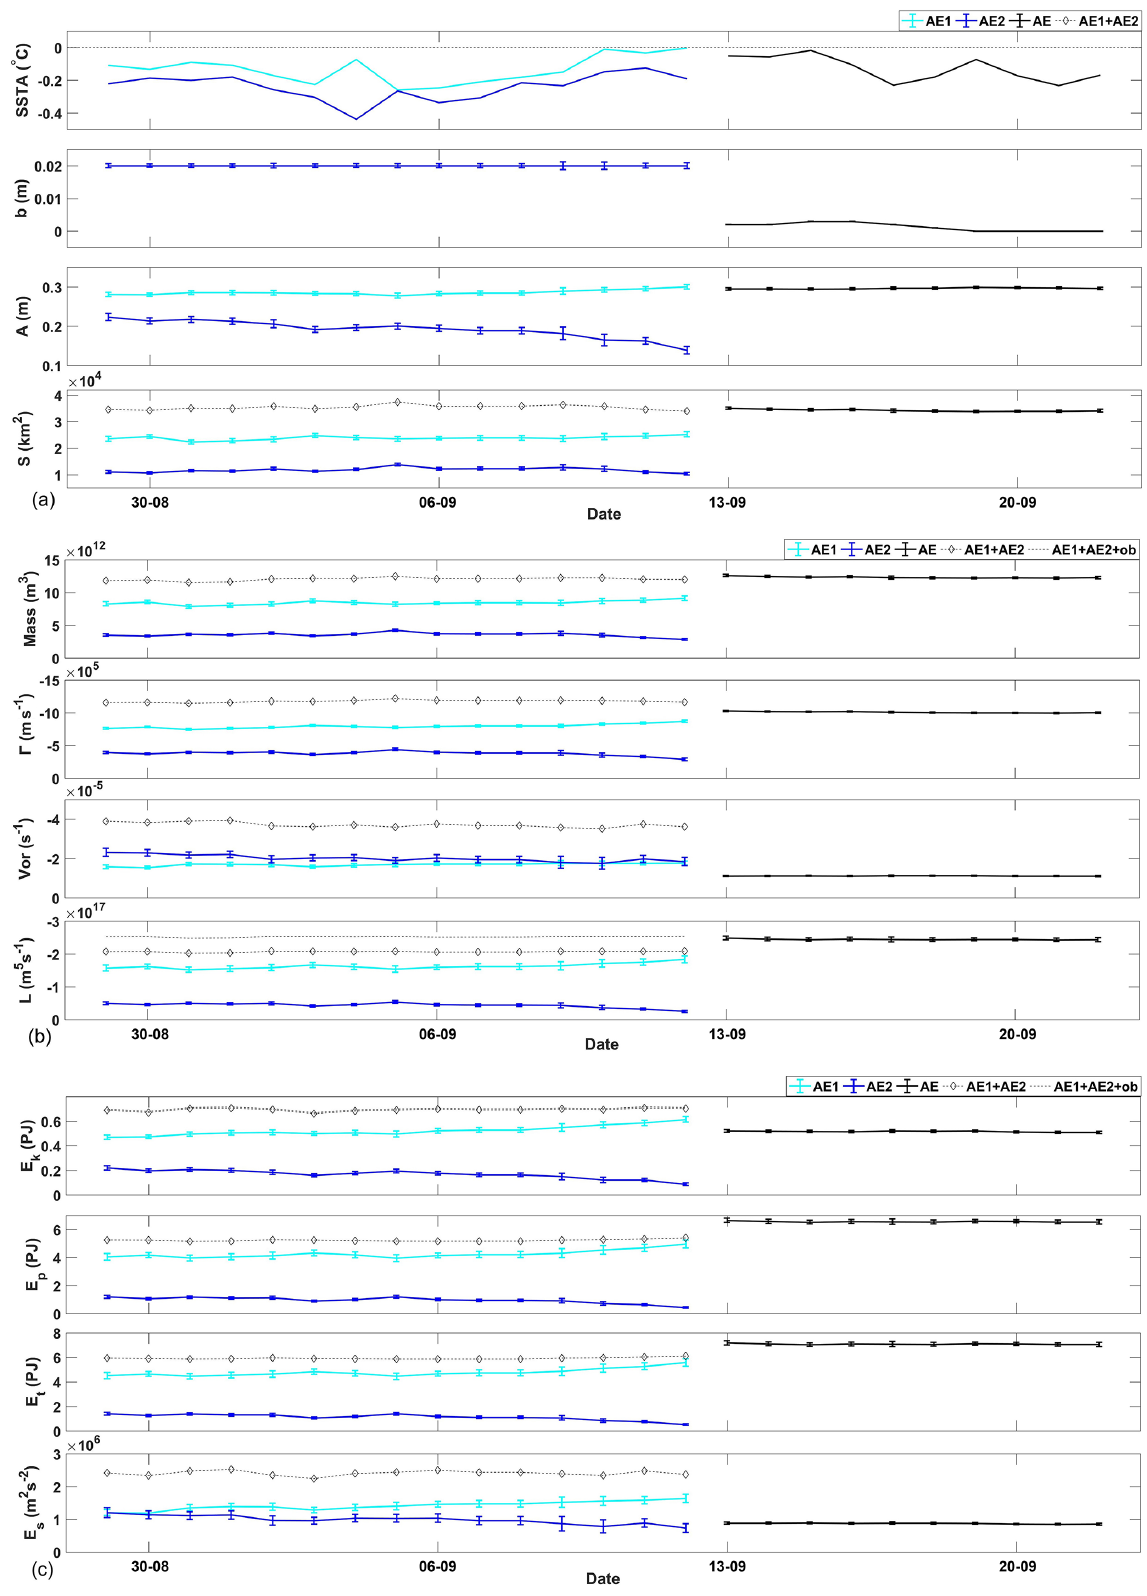
Figure 5. Same parameters as shown in Fig. 3 but for subsurface